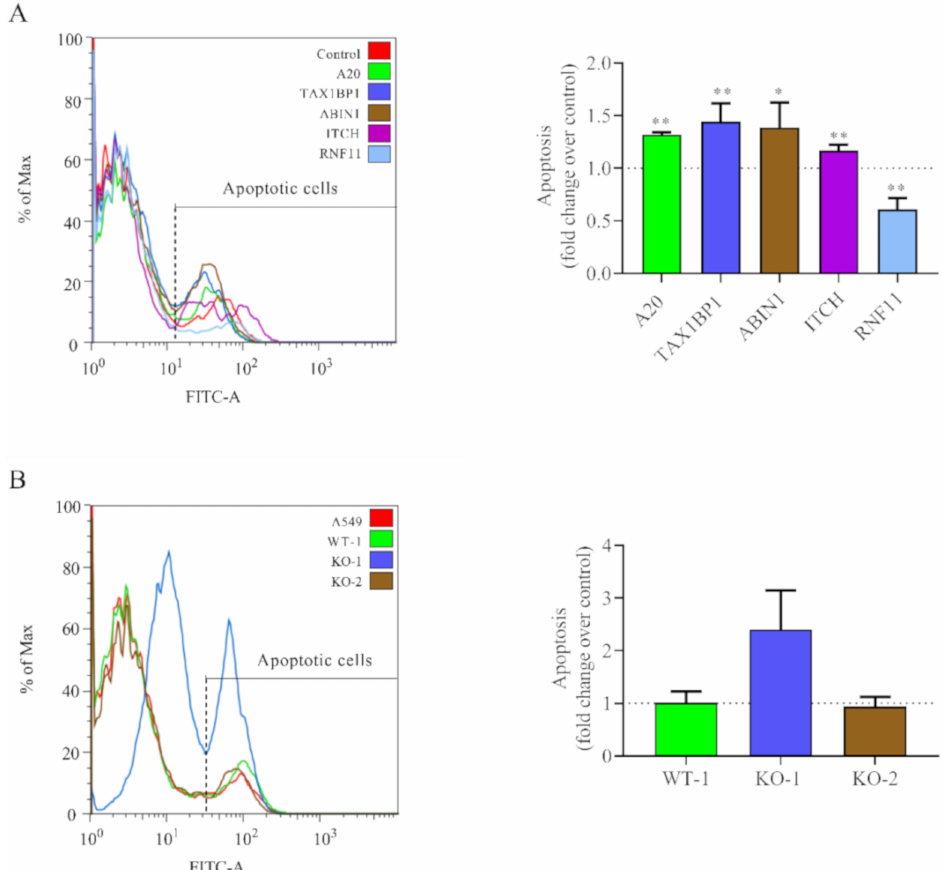
Figure 6. Apoptosis levels in siRNA-treated or A20 KO cells. ( A ) Cells were transfected with the indicated siRNAs (control, A20, TAX1BP1, ABIN1, ITCH, and RNF11) and infected 24 h later at a MOI of 3. ( B ) Wild-type and A20 KO cells were infected at a MOI of 3. In all cases, cells were harvested at 48 hpi and apoptosis was quantified via flow cytometry by AnnexiV-AlexaFluor488 TM and Sytox TM staining. The left panels show results from one representative experiment, and the right panels represent the mean (fold-over control) and standard deviation from three independent experiments. Controls are siRNA control in ( A ) and parental A549 cells in ( B ). Pairwise comparisons between cells treated with the siRNA control and a specific siRNA ( A ) or A549 cells with the cell lines (WT-1, KO-1 or KO-2) ( B ) were done by the t -test. From the p values obtained, FDRs were calculated: *, q-values < 0.05 and **, q-values <